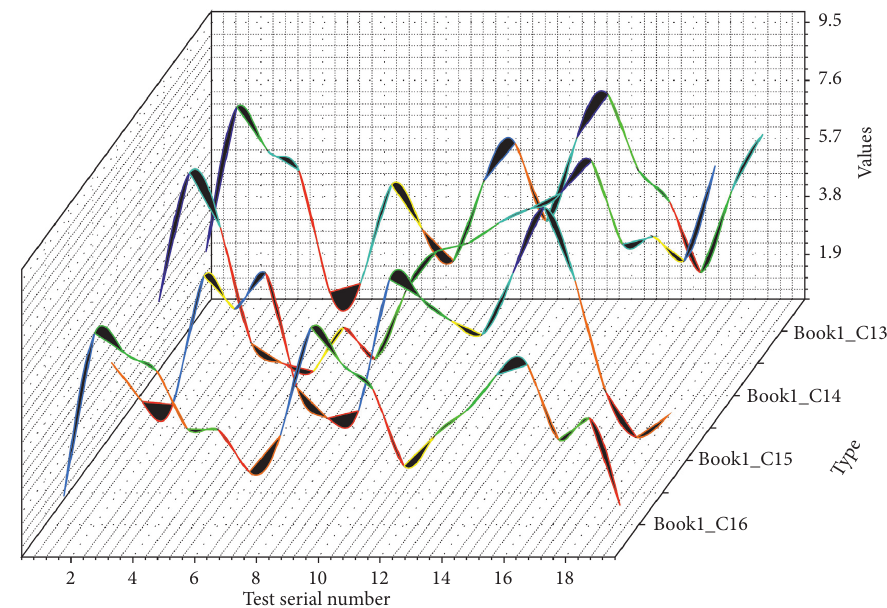
Figure 8: Uniform linear walking pedometer detection